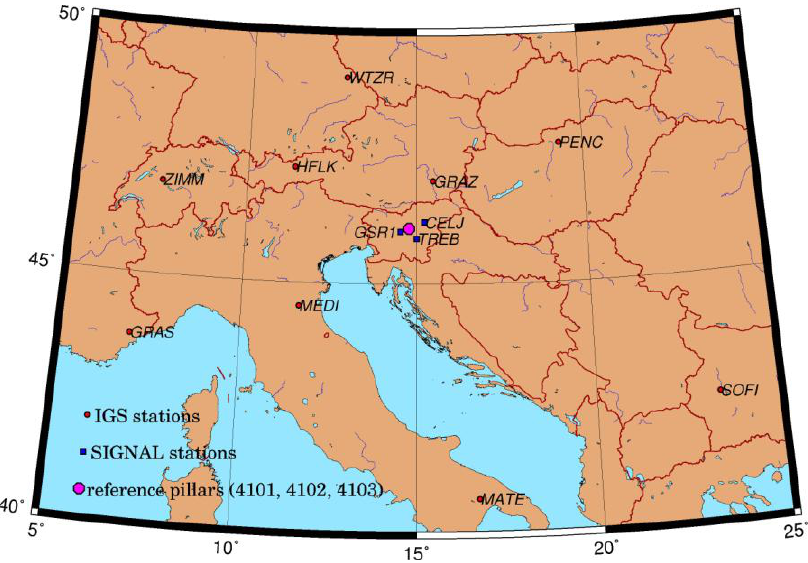
Figure 5. Locations of permanent GNSS stations.